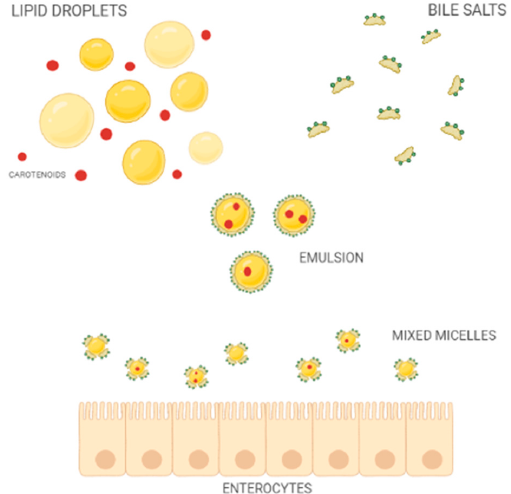
Figure 2. Schematic representation of mixed-micelle formation in the small intestine.